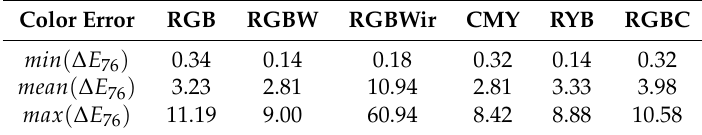
Table 5. Color performance of the sensor over the 24 patches of the X-Rite ColorChecker Classic. No training set have been used for the computation of color correction matrix (CCM).